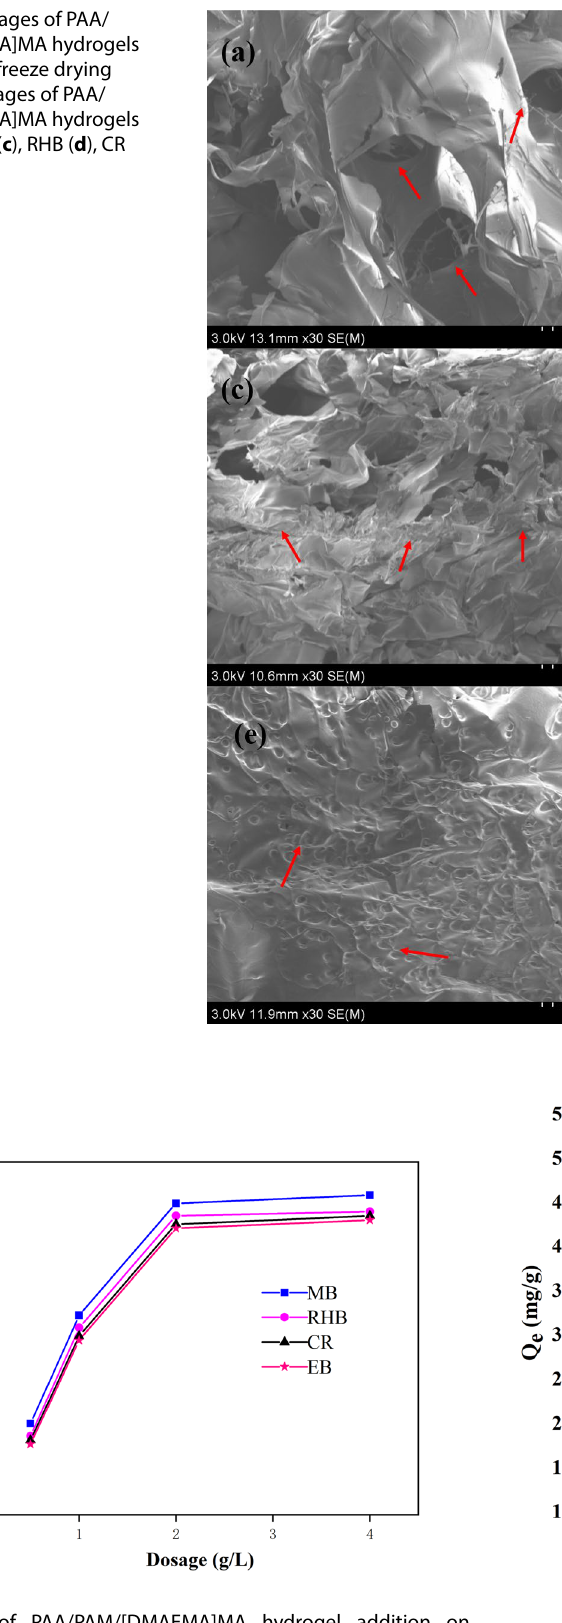
Fig. 5 The influence of pH value on the Q adsorbed by PAA/PAM/[DMAEMA]MA